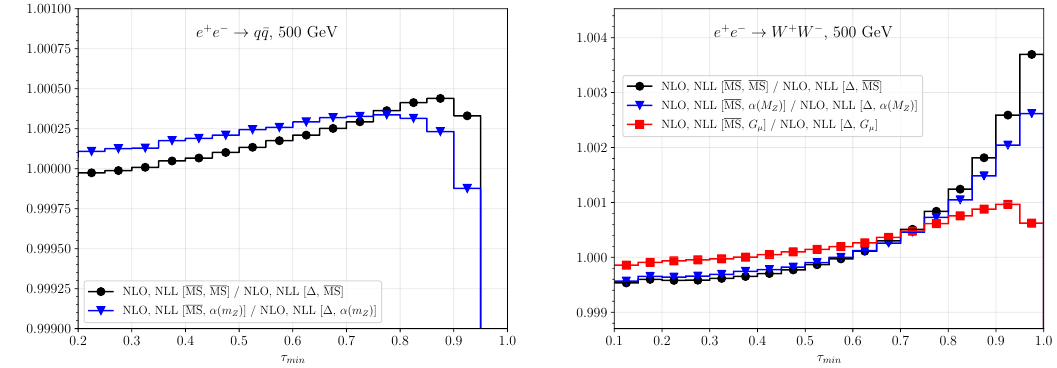
Figure 7 . Ratios of cross sections computed with NLL- MS PDFs over those computed with NLL- ∆ PDFs, for different choices of renormalisation scheme. Left panel: q ¯ q production; right panel: W + W −